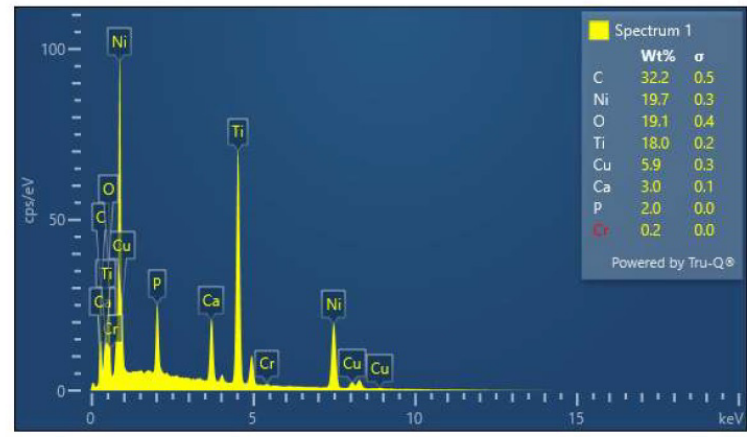
Figure 5. EDX of the nodular growth on surface of NiTi